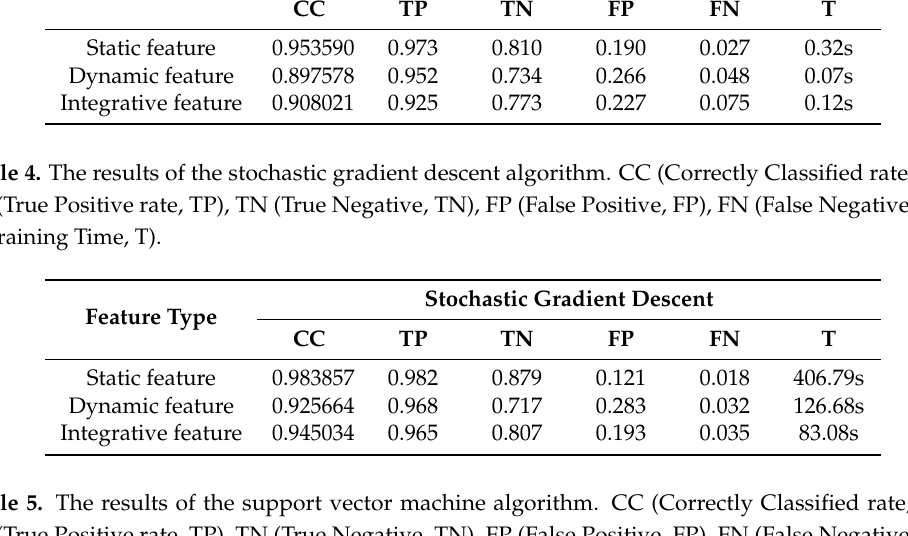
Table 5. The results of the support vector machine algorithm. CC (Correctly Classified rate, CC), TP (True Positive rate, TP), TN (True Negative, TN), FP (False Positive, FP), FN (False Negative, FN), T (training Time, T).